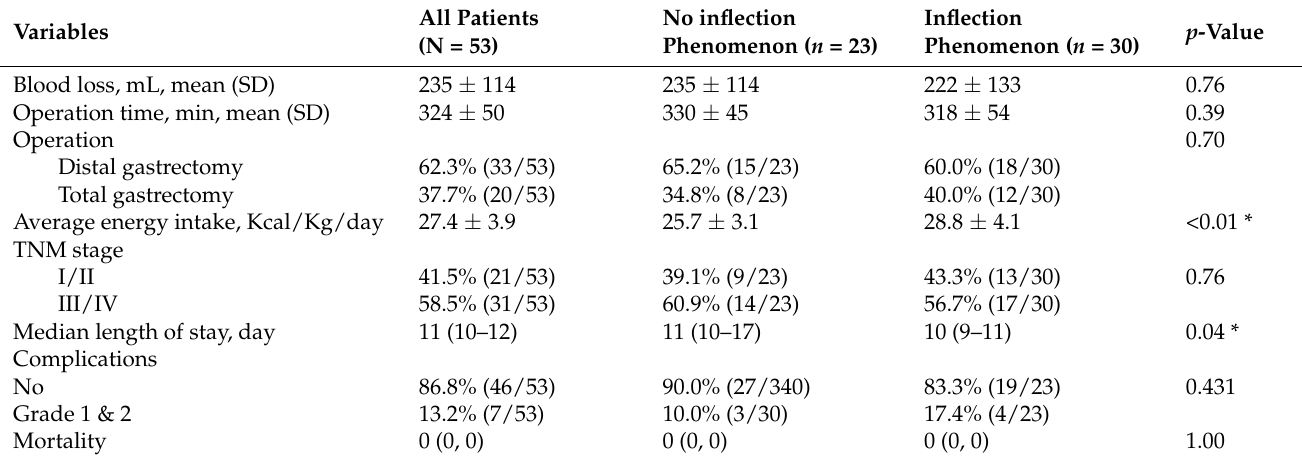
Table 2. The perioperative characteristics of all patients ( n =